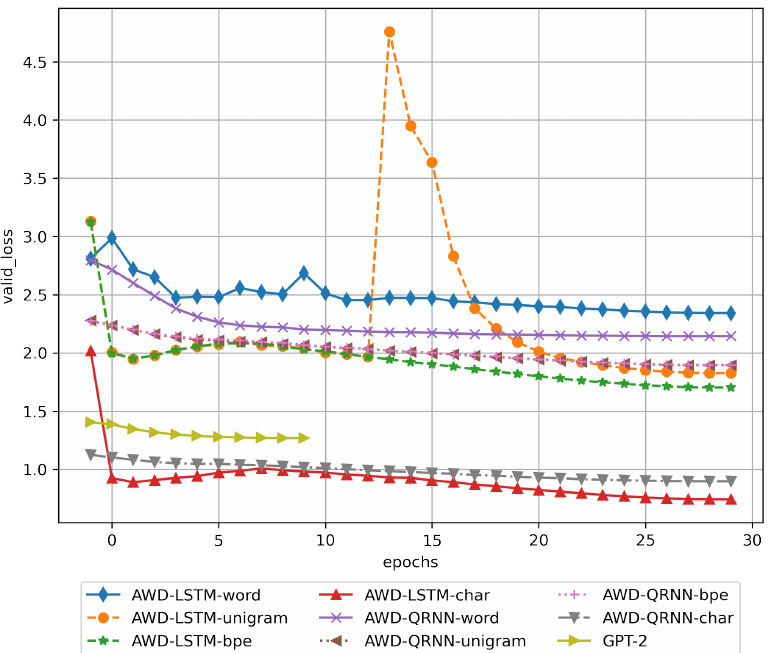
Figure 5. Evolution of the validation_loss of DNNs devoted to generating source code during the training epochs.